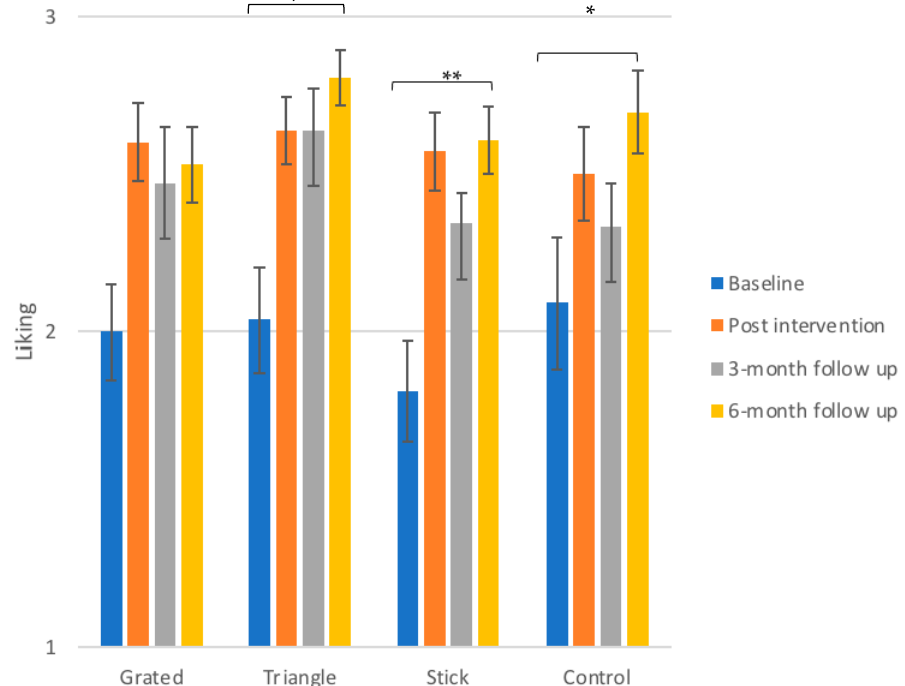
Figure 1. Mean liking scores ± SEM of daikon for the three different exposure groups in the control sessions. The significance of the overall differences only (baseline to 6-month follow up) for the groups of triangles, sticks and the control group are depicted. The overall increase in liking of daikon was not found significant for the group that received grated daikon. The detailed differences and their statistical significance are given in text. Significance levels: ** p ≤ 0.01, * p ≤